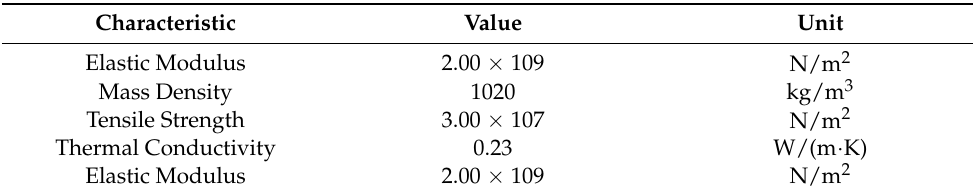
Figure 8. Torveastro CAD: ( a ) Motor Unit detail, ( b ) Arm Detail, ( c ) Full assembly. Table 1. ABS